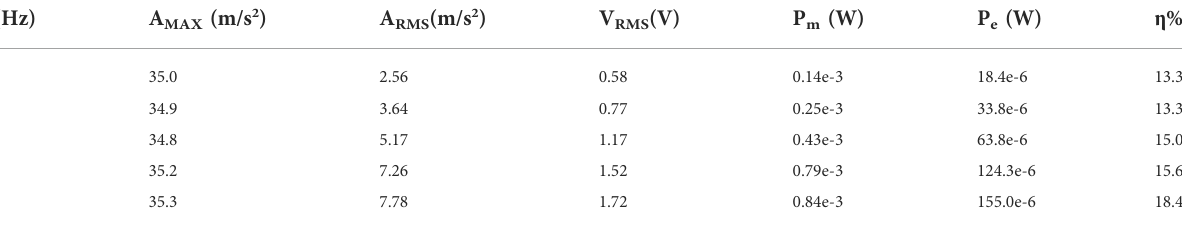
TABLE 2 The energy conversion ef fi ciency of the harvester investigated in [14], for the range of frequencies 0.5 – 5 Hz ( © 2017 IEEE).